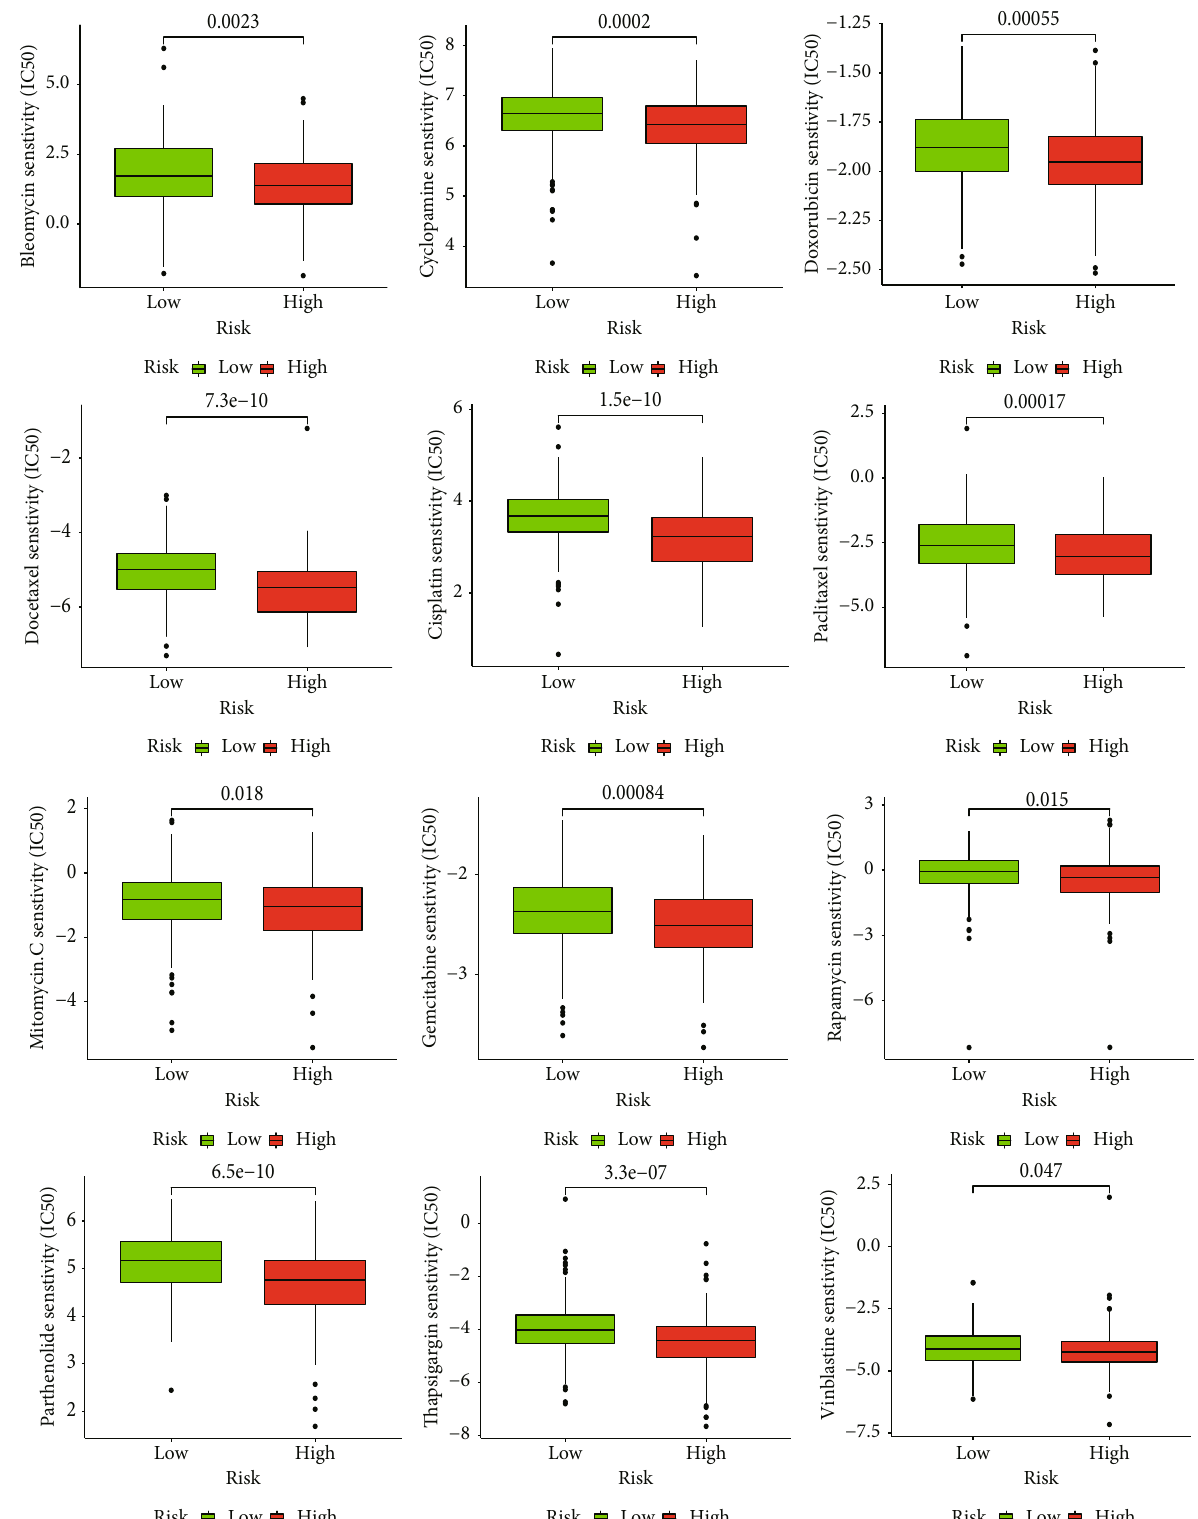
Figure 7: Comparison of the estimated IC50 values of Bleomycin, Mitomycin C, Gemcitabine, Cyclopamine, Docetaxel, Cisplatin, Paclitaxel, Rapamycin, Parthenolide, Thapsignargin, Vinblastine, and Doxorubicin in the high- and low-risk BLCA samples by using the GDSC